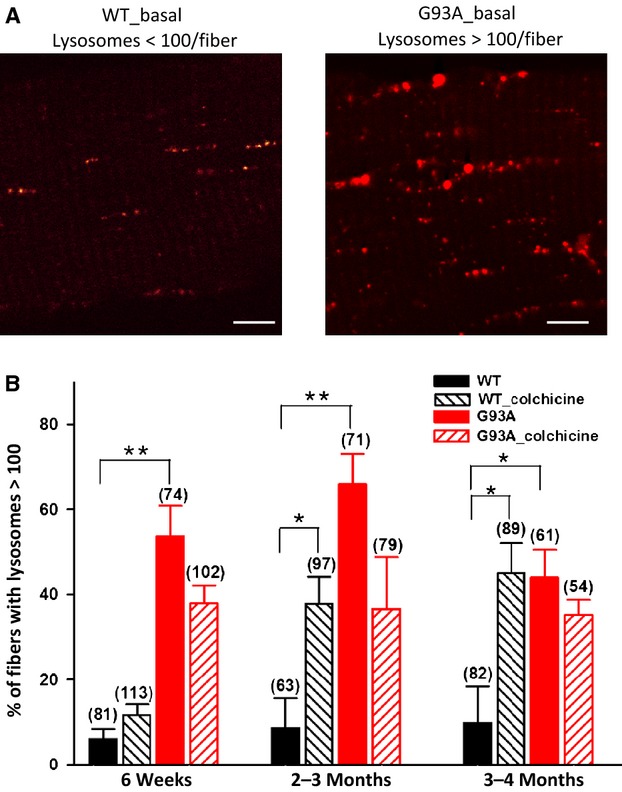
Lysosome formation in muscle fibers under basal and autophagy induction conditions. Both G93A and control (WT) FDB muscle fibers were labeled with LysoTracker Green. Under normal diet (basal condition), the majority of individual WT muscle fibers contains <100 lysosomes/fiber, while the majority of G93A fibers contains lysosomes more than 100/fiber. (A) Representative images of individual WT and G93A FDB muscle fibers under basal condition. (B) The percentage of fibers containing lysosomes more than 100/fiber was quantified for each group. Note, under basal condition, G93A muscle fibers have shown significant more numbers of lysosomes/fiber at all age groups. WT muscle fiber (older than 2 months) responded to the autophagy induction procedure (WT_colchicine) with dramatically increased formation of lysosomes. However, G93A muscle fibers (G93A_colchicine) showed no further increase in lysosomes formation following the same procedure. The number on the top of each bar represents the number of FDB fibers included in each group, 3‐5 mice/group, *P < 0.05, **P < 0.01. Bar: 10 μm.